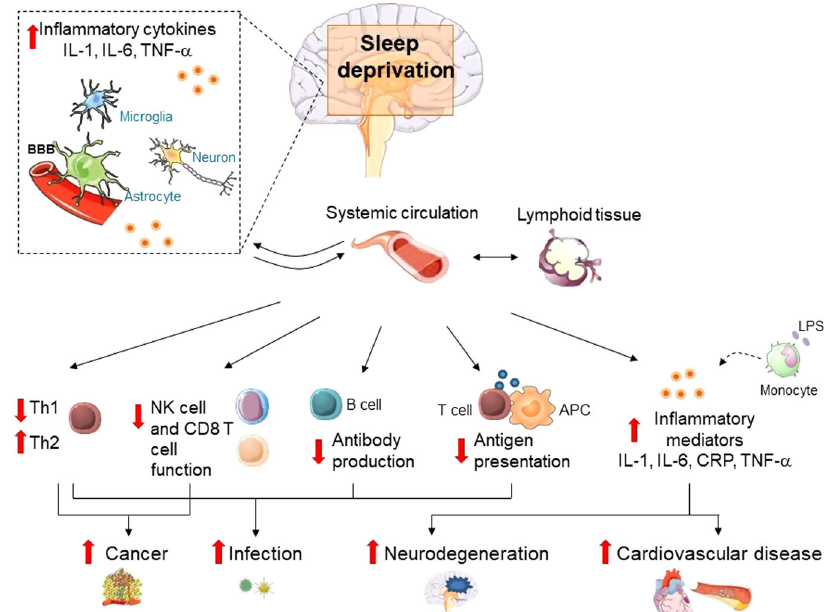
Fig. 2 Immune consequences of sleep deprivation. Sleep deprivation, as induced experimentally or in the context of habitual short sleep, has been found to be associated with alterations in the circulating numbers and/or activity of total leukocytes and speci fi c cell subsets, elevation of systemic and tissue (e.g., brain) pro-in fl ammatory markers including cytokines (e.g., interleukins [IL], tumor necrosis factor [TNF]- α ), chemokines and acute phase proteins (such as C reactive Protein [CRP]), altered antigen presentation (reduced dendritic cells, altered pattern of activating cytokines, etc.), lowered Th1 response, higher Th2 response, and reduced antibody production. Furthermore, altered monocytes responsiveness to immunological challenges such as lipopolysaccharide (LPS) may contribute to sleep deprivation-associated immune modulation. Hypothesized links between immune dysregulation by sleep deprivation and the risk for immune-related diseases, such as infectious, cardiovascular, metabolic, and neurodegenerative and neoplastic diseases, are shown. The illustrations were modi fi ed from Servier Medical Art (http://smart.servier.com/), licensed under a Creative Common Attribution 3.0 Generic License. APC: antigen- presenting